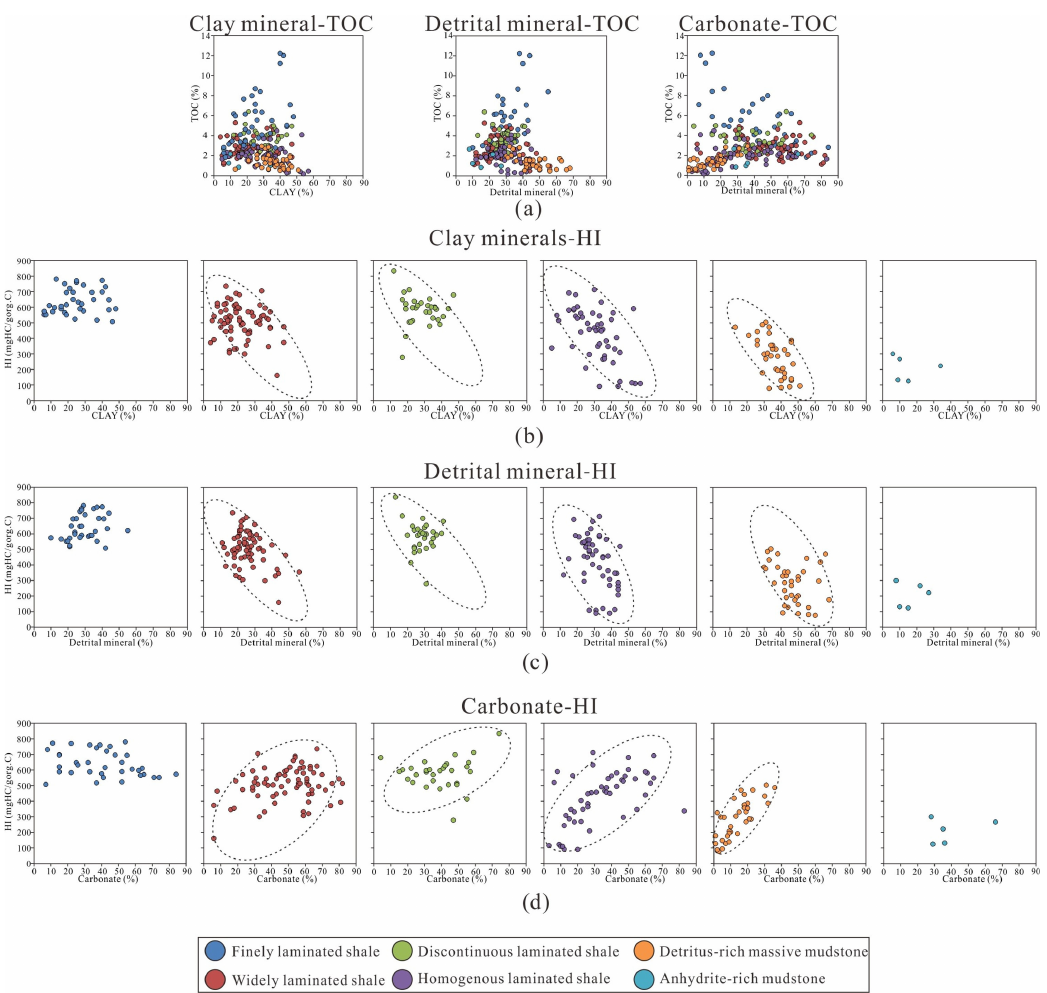
Figure 8. Correlation between mineral constituents and pyrolysis parameters. ( a ) Relationships between mineral contents and TOC in different lithofacies; ( b – d ) Relationships between various mineral contents and HI in different